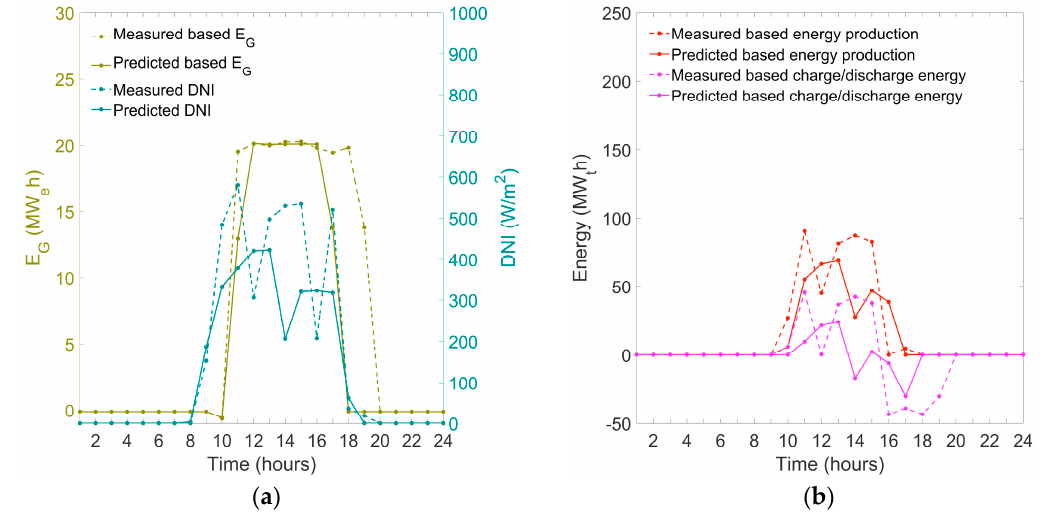
Figure 5. Comparison between results of the SAM simulation results for 11 January (prediction of low energy with clouds), with predicted and measured ( a ) hourly mean DNI (W/m²) values (blue) and produced electrical energy E G (MW e h) values (green); and ( b ) thermal energy (MW t h) of charge/discharge values (purple) and produced solar energy (red).